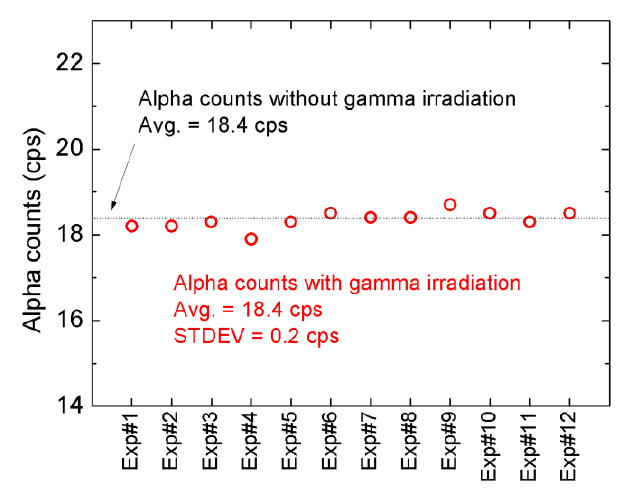
Fig. 8. Alpha counts before and during gamma